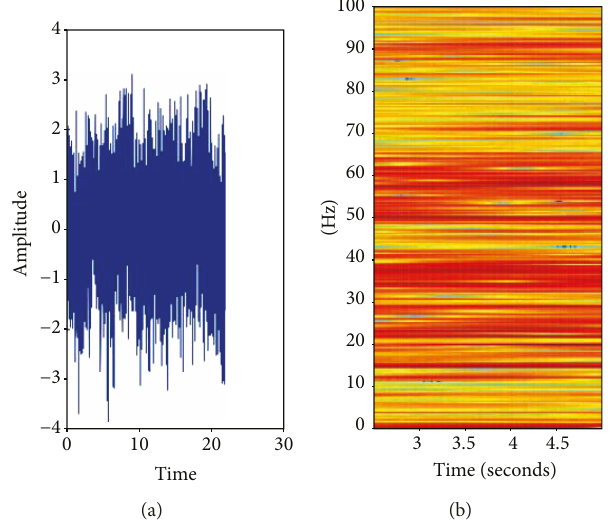
Figure 5: Signal time series (a) and STFT (b) when no fl utter occurs.